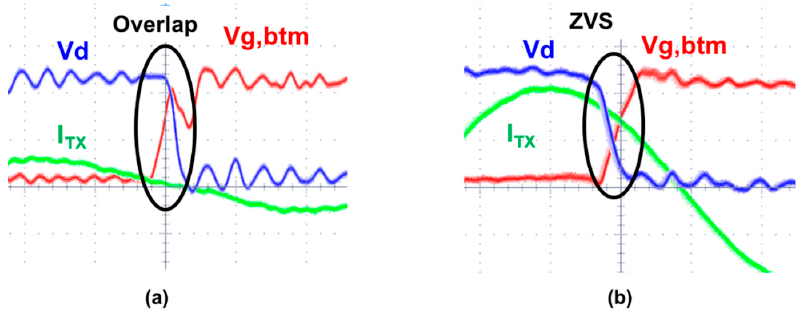
Figure 5. ( a ) Measured 6.78 MHz inverter waveforms at 1.1 cm distance (excessive reflected resistance). Gate is turned on before Vd drops to zero, causing switching losses. ( b ) 2.9 cm separation (moderate reflected resistance). Zero-voltage switching (ZVS) is achieved.